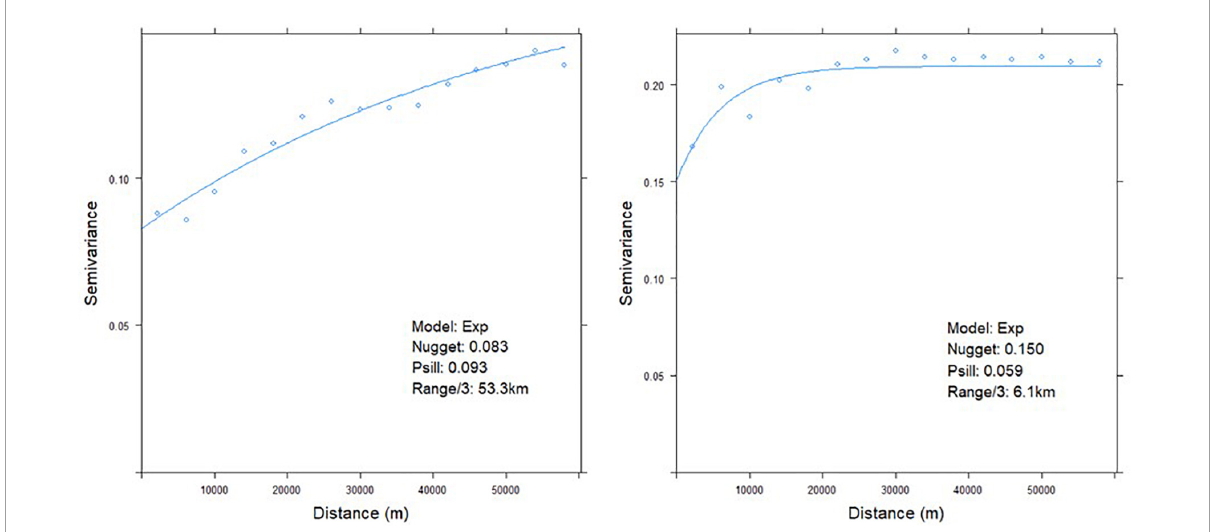
FIGURE2 Fitted variogram mode of the generalized linear model (GLM) residuals ( left: Ambrosia artemisiifolia , right: Ambrosia trifida ).